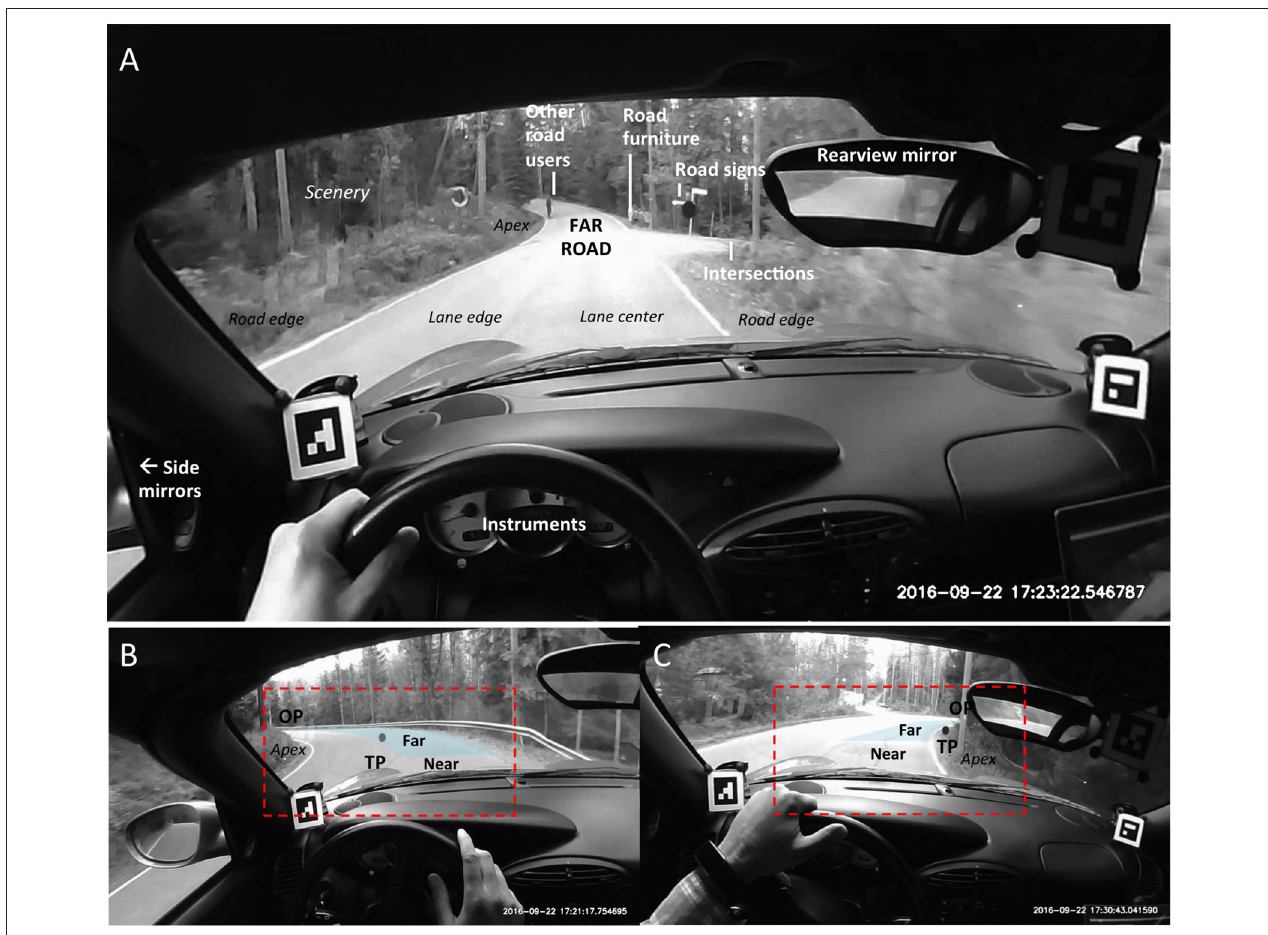
FIGURE 2 | (A) Descriptive classification of fixations used in this study, shown here in representative video frames on a straight. (B,C) Illustrate The Far Road “triangle” in a left turn (B) and a right turn (C) . See also Figure 4 . OP, Occlusion Point; TP, Tangent Point. See main text for explanation.